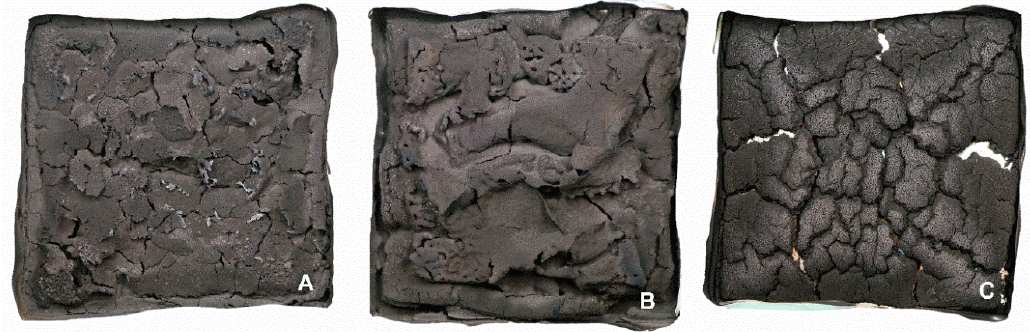
Figure 15. Cone calorimeter residue photographs of TPS/10APP ( A ), TPS/20KF/10APP ( B ) and TPS/20CF/10APP ( C ).